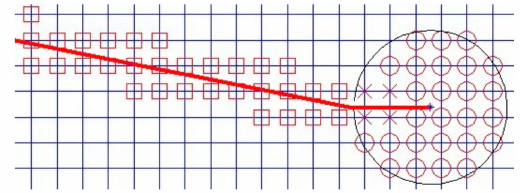
Figure 2. Selection of the strengthening nodes.